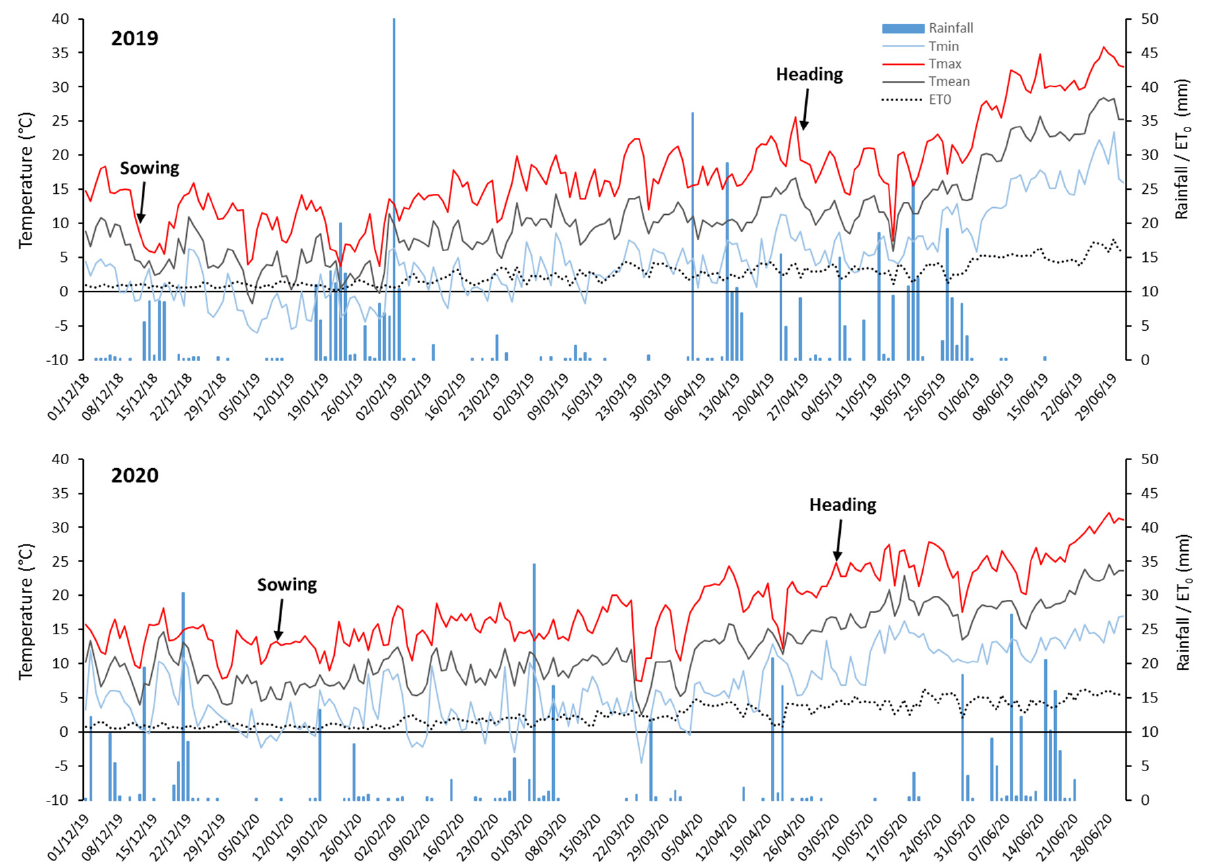
Figure 3. Meteorological data at the experimental site in Viterbo (Italy) during the 2019 and 2020 growing seasons; Tmin, Tmax and Tmean, minimum, maximum and mean daily temperature, respectively; ET 0 , daily evapotranspiration.